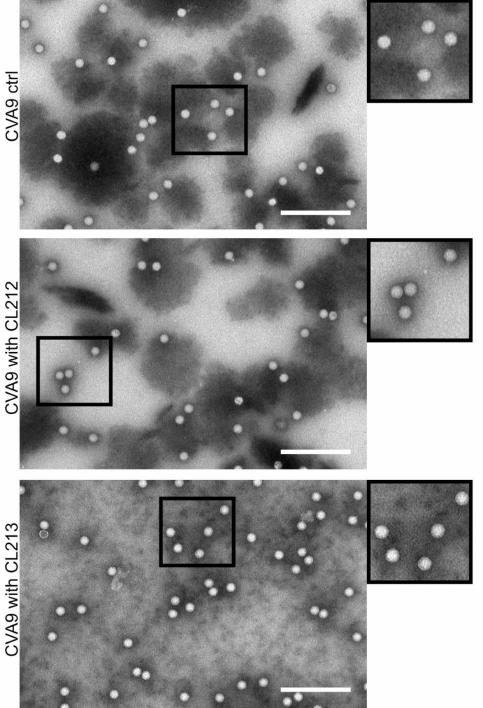
Figure 7. TEM images of CVA9 (1 µ g) after being treated with 100 µ M CL212 and CL213 for 1 h at +37 ◦ C, and a control with no drug treatment. Scale bars 200